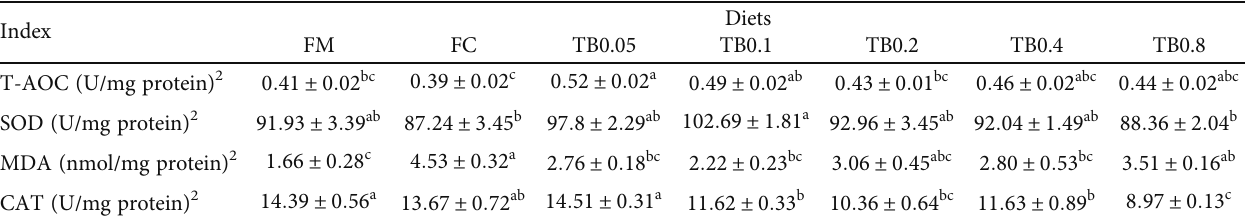
Table 8: E ff ects of tributyrin supplementation on activities of MDA content and antioxidant enzymes in the intestine of juvenile large yellow croaker fed diets with high level of Clostridium autoethanogenum protein replacing fi sh meal ( means ± SEM, n = 3 ) 1 .